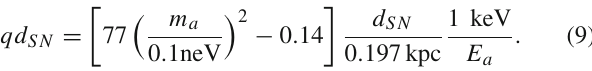
Fig. 1 ν BADM flux for the benchmark values g a ν = 3 GeV − 1 , m ν = 50 meV and two axion masses, m a = 10 − 11 eV (black solid line) and m a = 10 − 12 eV (red line). For comparison, the SN Primakoff flux for massless axions with a coupling g a γ = 10 − 12 GeV − 1 (black dashed line) is shown. These fluxes refer to a SN at d SN = 0 . 197